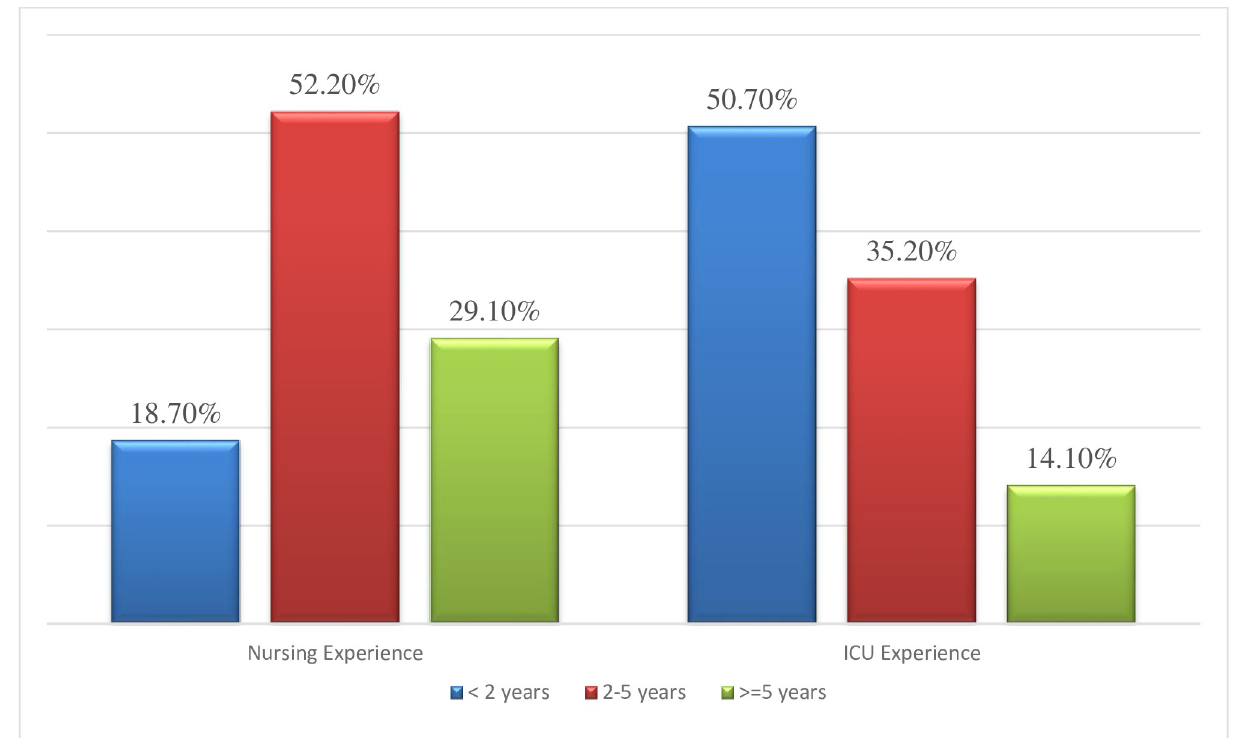
Fig 2. Working experience of nurses in intensive care units of Amhara region public hospitals, Amhara, Ethiopia. 2020.